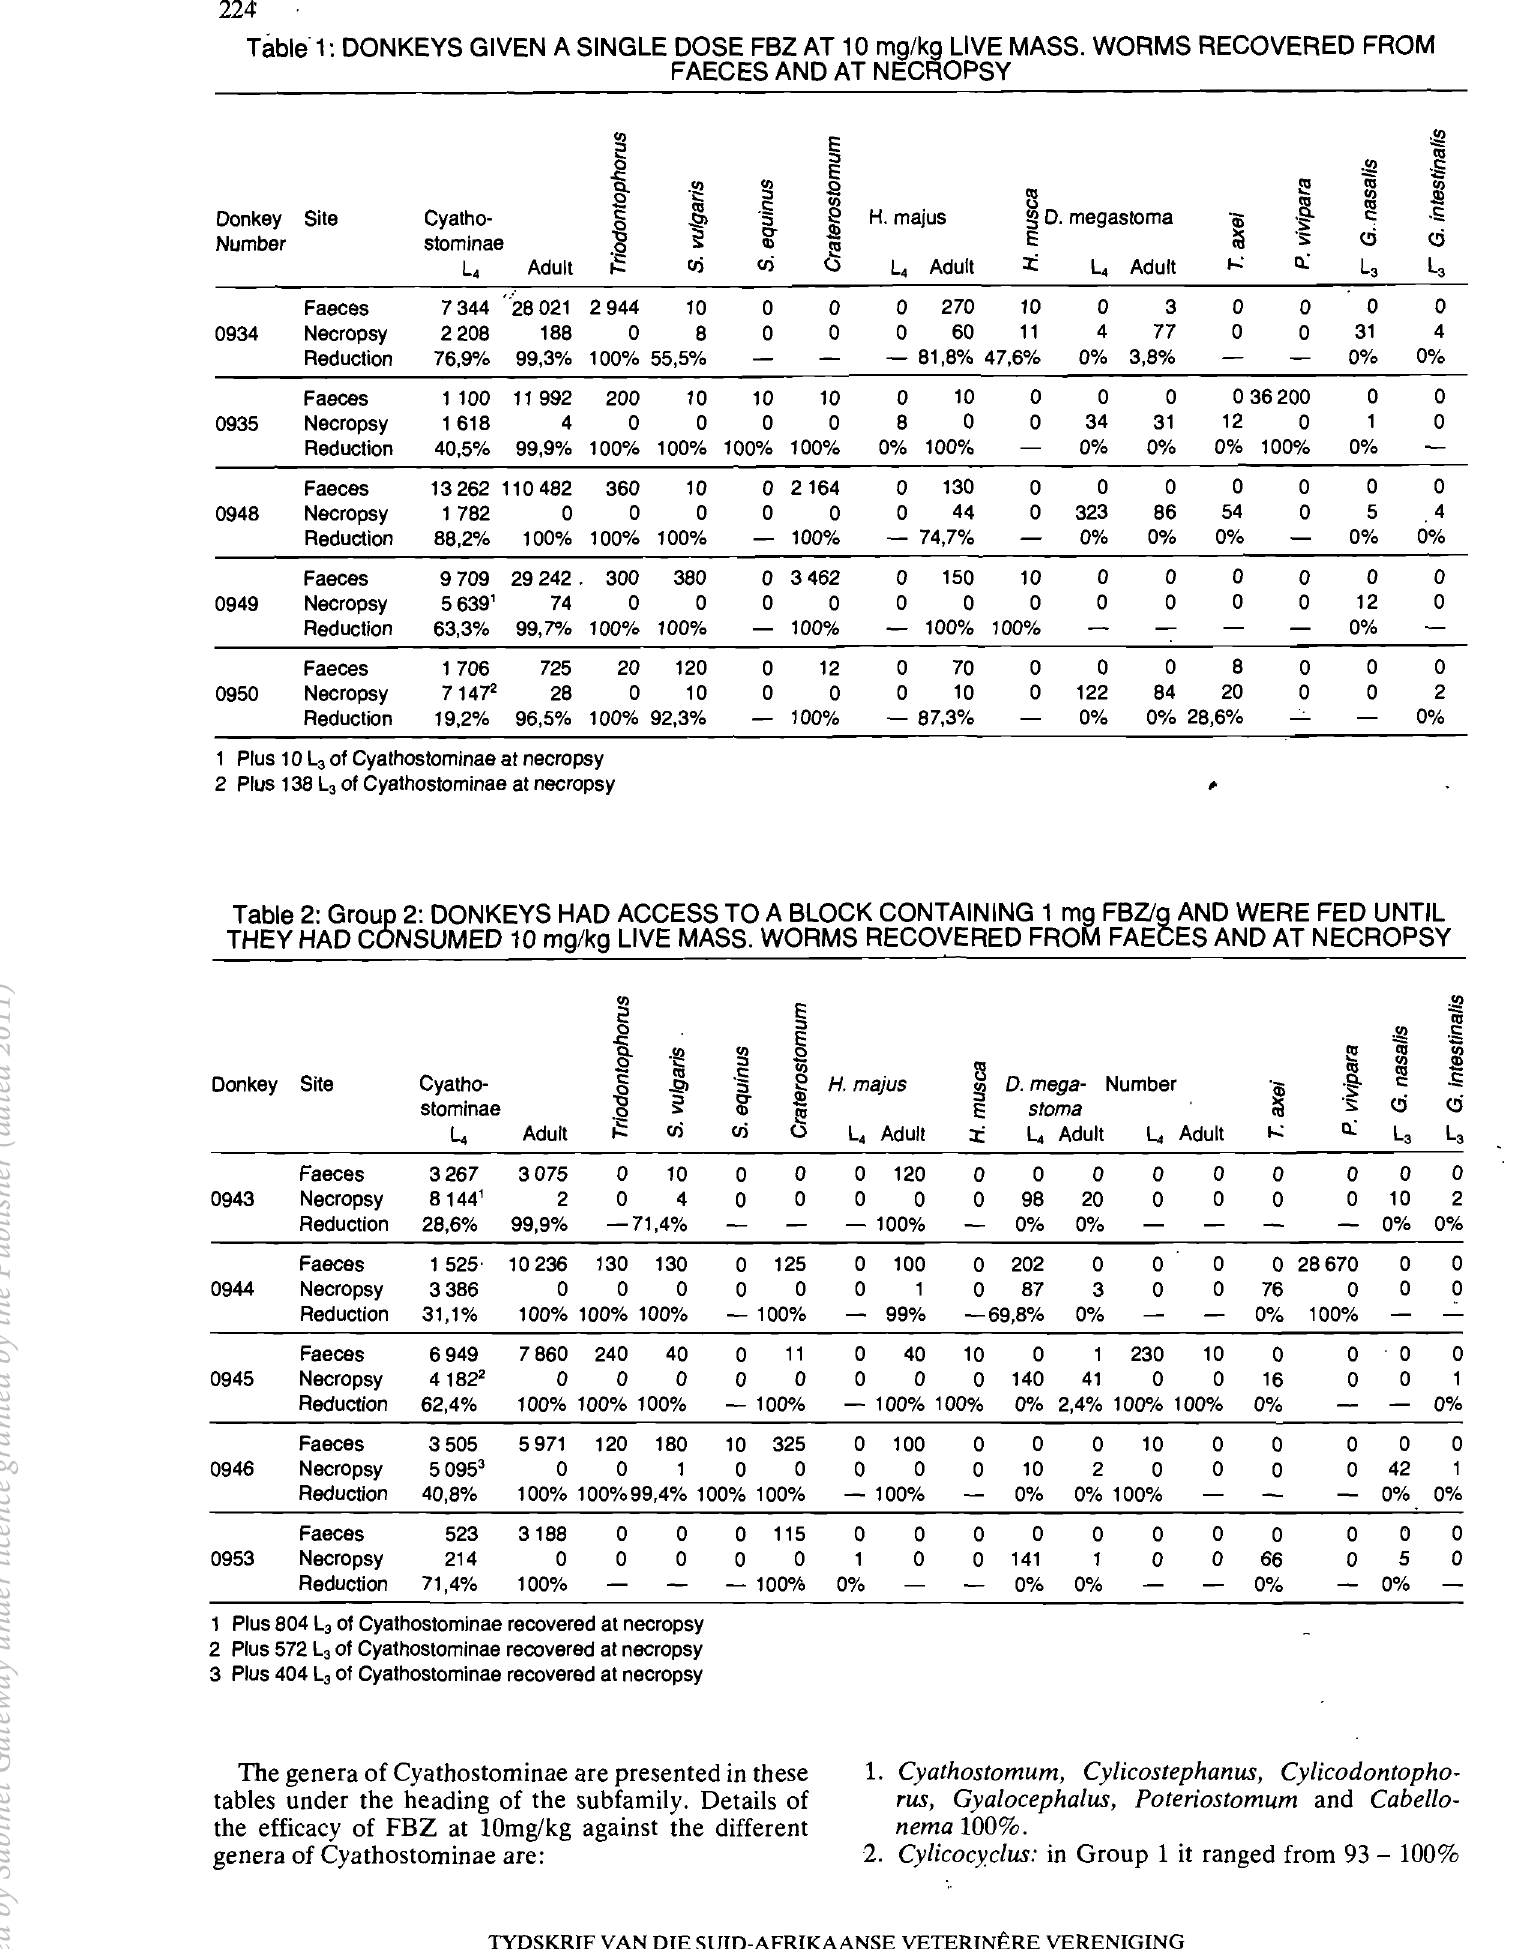
Table' 1 : DONKEYS GIVEN A SINGLE DOSE FBZ AT 10 mg/kg LIVE MASS. WORMS RECOVERED FROM FAECES AND AT NECROPSY